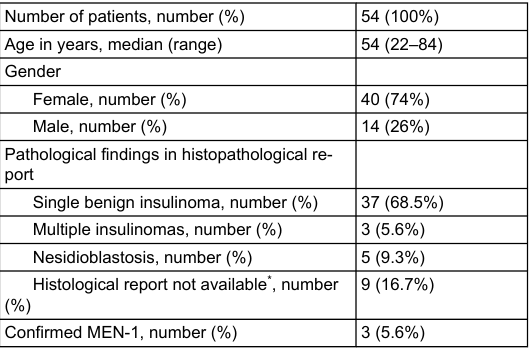
Table 1: Clinical characteristics of the patients with endogenous hy- perinsulinaemic hypoglycaemia (EHH).